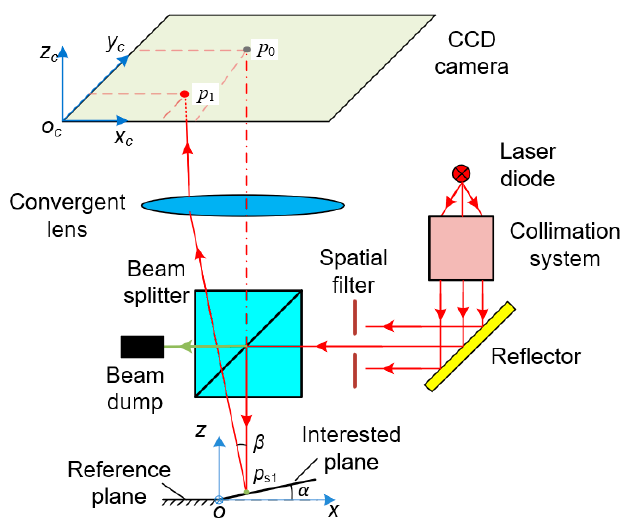
Figure 2. Schematic diagram of the slope sensor.